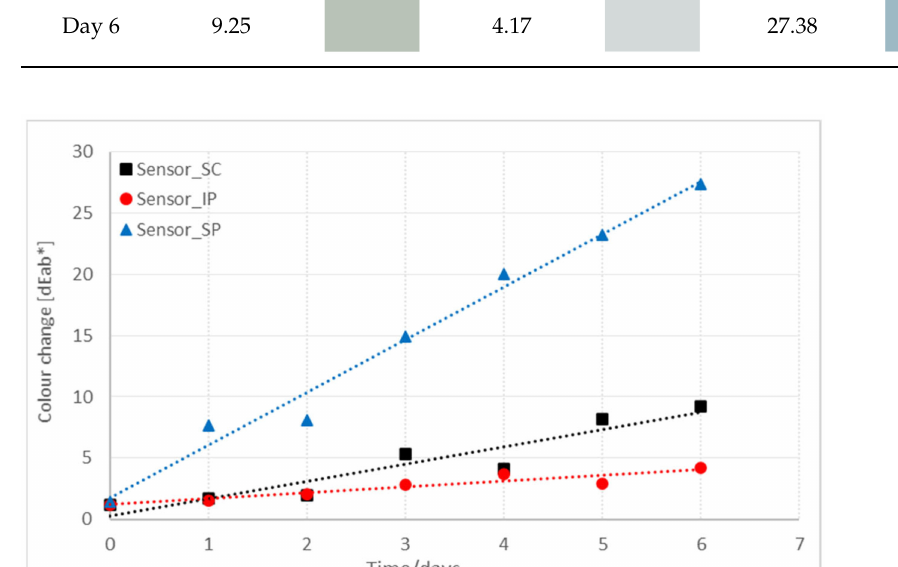
Figure 8. Colour change of three different sensor layers (SC, IP, SP) in the presence of fish meat over